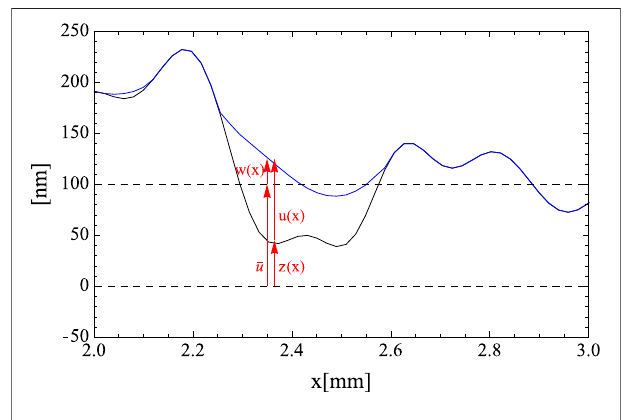
FIGURE 3 | Schematic of the generic cross section of the contact geometry, used to derive Eq. 18 .